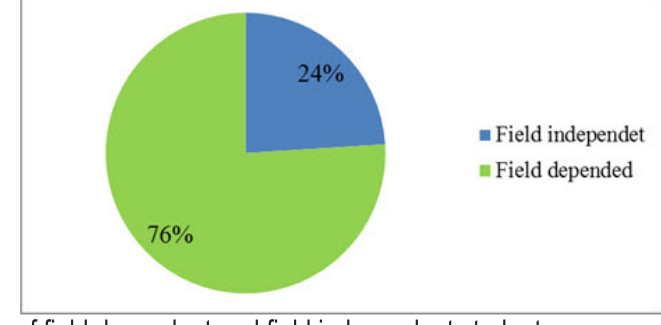
Figure 1. Ratio of field dependent and field independent